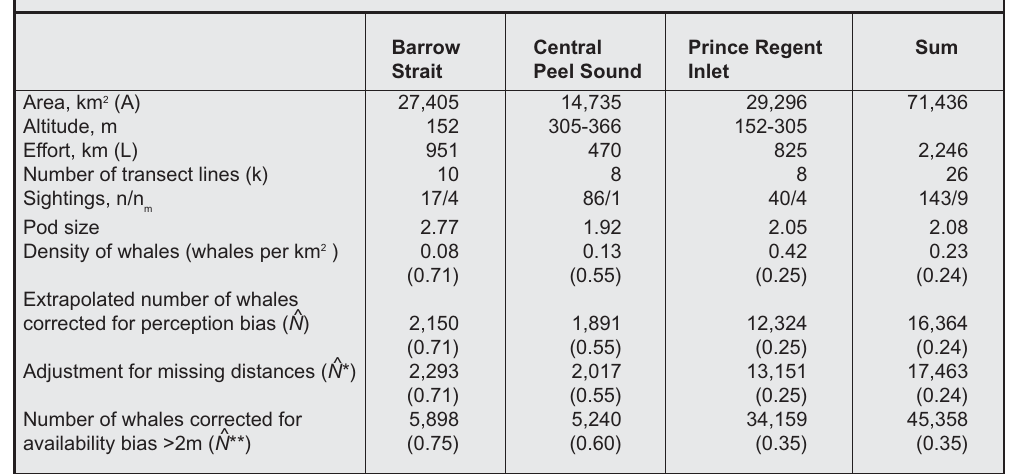
Table 6 . Survey estimates of narwhal abundances in three regions (see Fig. 6) in the Canadian High Arctic in July-August 1996. The density in the inadequately surveyed northern part of Peel Sound is assumed to be similar to the density in central Peel Sound. The sightings are given as the total number of sightings (n) and the number with missing distances (n ber of narwhals is corrected for an estimate of availability bias of 0.38 (cv=0.25). Coefficient of variation is shown in